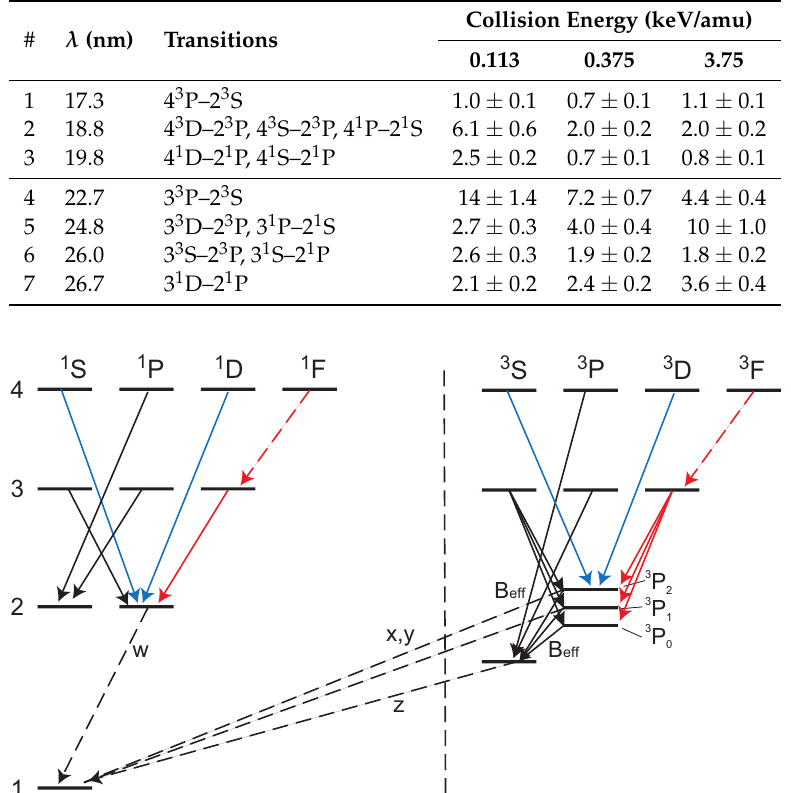
Table 1. Fit results—measured emission cross-sections for collisions between C 5 + and H 2 O, at different collision energies. All cross-sections are in units of 10 − 16 cm 2 . Only relative errors are given. The systematic uncertainty is approximately 20% for wavelengths above 20 nm and 25% for the shorter wavelengths, see text.